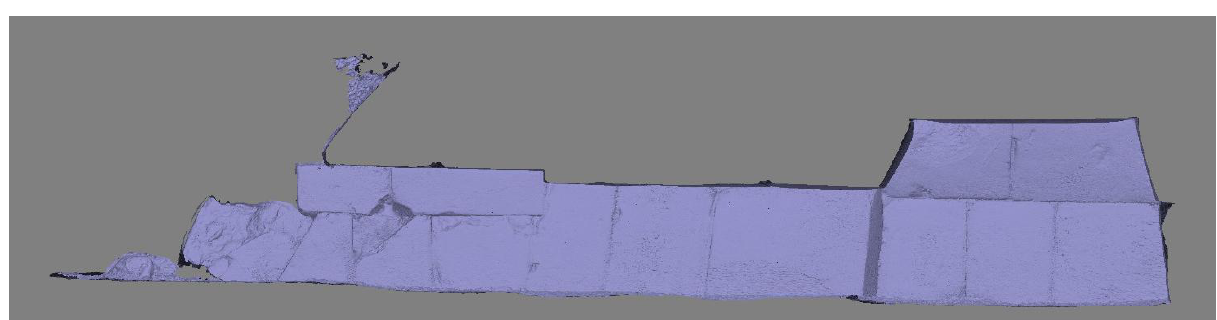
Figure 7. 3D model of the stone chamber in the Bentenzuka burial mound by SfM (Textured).